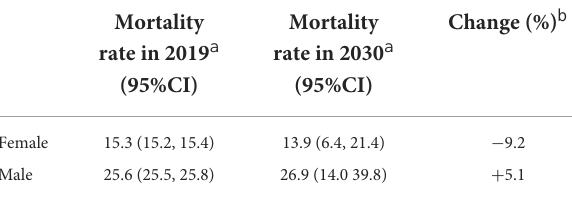
TABLE 2 Projected obesity-attributable stroke mortality rate by sex (20–79